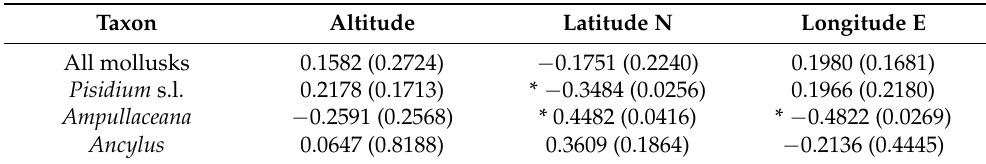
Table A1. Spearman correlation and associated significance in parenthesis ( p -values) of mollusk abundance values concerning altitude, longitude, and latitude. Only lakes where the taxon of interest is present were considered. Asterisks highlight the level of significance achieved: *, p < 0.05.